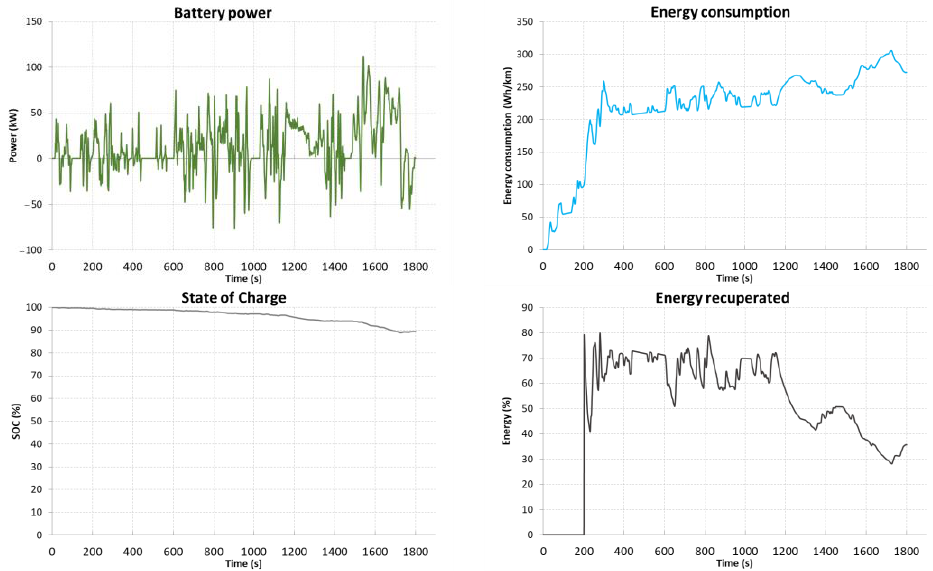
Figure 11. WLTP results of simulation tests for the 4 × 4 drive system with Type 1 energy storage.